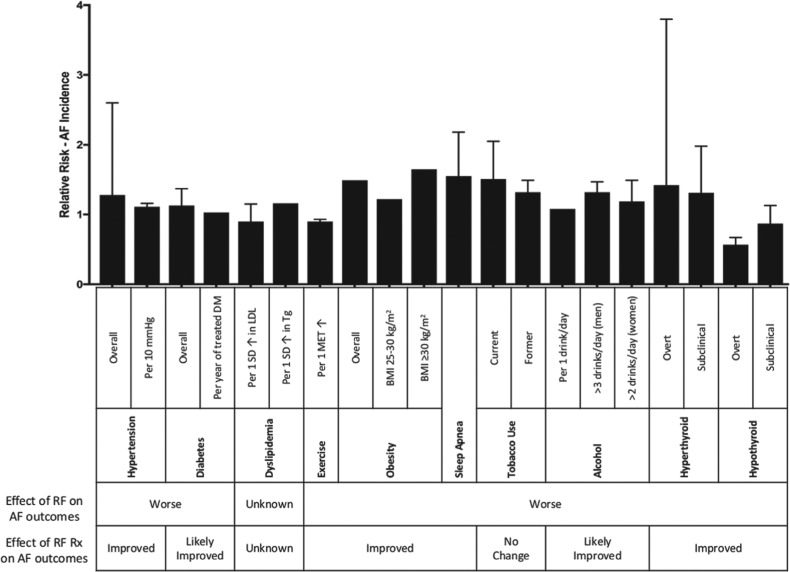
Relationship between modifiable cardiovascular risk factors, AF incidence, and AF outcomes. AF: atrial fibrillation; BMI: body mass index, DM: diabetes mellitus; LDL: low-density lipoprotein; MET: metabolic equivalent; RF: risk factor; SD: standard deviation; Tg: triglycerides.